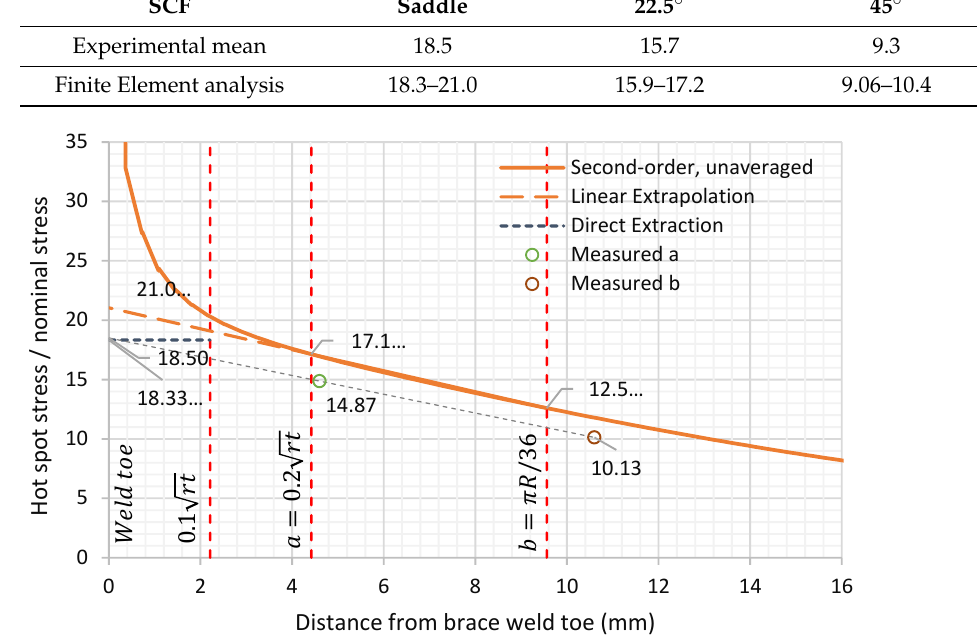
Figure 18. SCF based FEA compared to SCF from specimen DT 1 — quadrant 3. Estimation of SCFs by the aid of FEA was highly dependent on the user judgement. The SCFs values can change by the type of elements selected, mesh density and SCF extrapolation method. Four different SCF estimation methods from the FEA are shown in this paper, in which all of these models were valid as per codes and